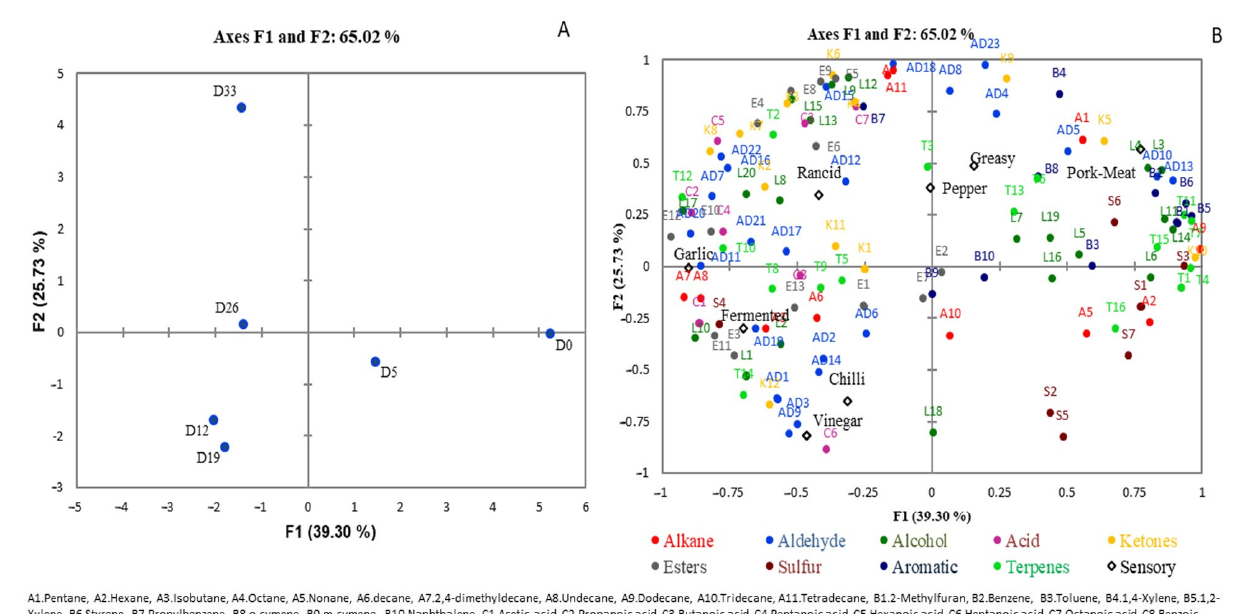
Figure 2. ( A ) Map of days of ripening, D0, D5, D12, D19, D26, and D33. ( B ) Evolution of the groups of volatile compounds and eight odors in chorizo samples using a Multifactor Analysis (MFA). Sulfur compounds such as allyl mercaptan (S1) and allyl sulfide (S4) showed a slight increase (not significant p > 0.5), Table S2, but allyl methyl sulfide (S2) and dimethyl di- sulfide (S3) decreased significantly ( p > 0.05). In general, sulfur compounds decreased dur- ing ripening, and Gorraiz et al. [52] reported a similar finding for this group of com- pounds. Some sulfur compounds came from the meat, and these were formed from the degradation of amino acids with sulfur content, such as methionine, cysteine, and cyste- ine, via Strecker degradation to thiols [53], as well terpenes, like styrene, which came from the meat as a consequence of their presence in animal feedstuff [11], so the relationship between sulfur and terpene compounds with pork meat odor was expected.